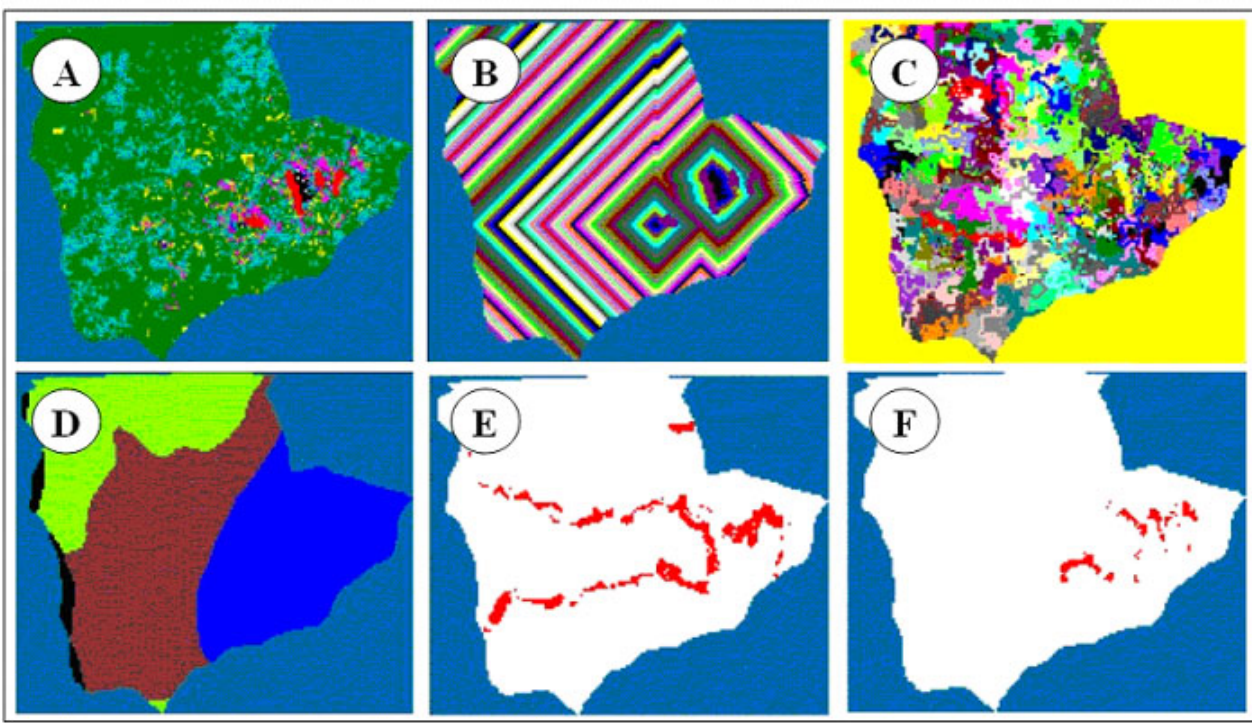
Fig. A2-1. Different views of the environment and the agents after 10 time steps in a village of Cho Don District. (A) Land use/land cover; (B) remoteness or distance to residential areas; (C) land ownership, i.e., all the cells of a particular color belong to the same agent, except for the yellow cells, which are not allocated; (D) soil types; (E) land suitable for terracing paddy fields in red, with access to water for irrigation; (E) land suitable for continuous maize cropping on the hillsides in red, flat land on soils derived from